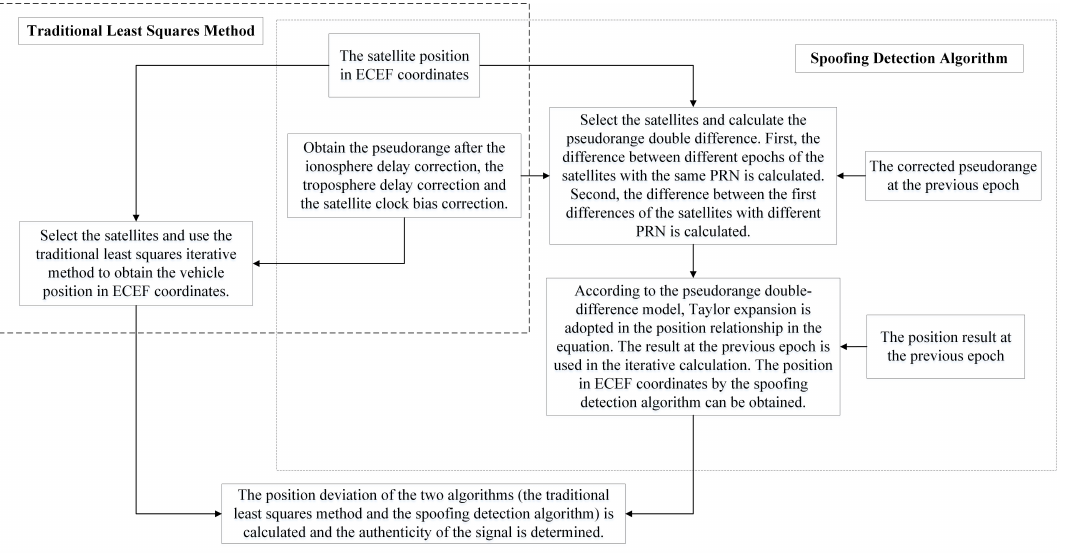
Figure 2. The detailed spoofing detection